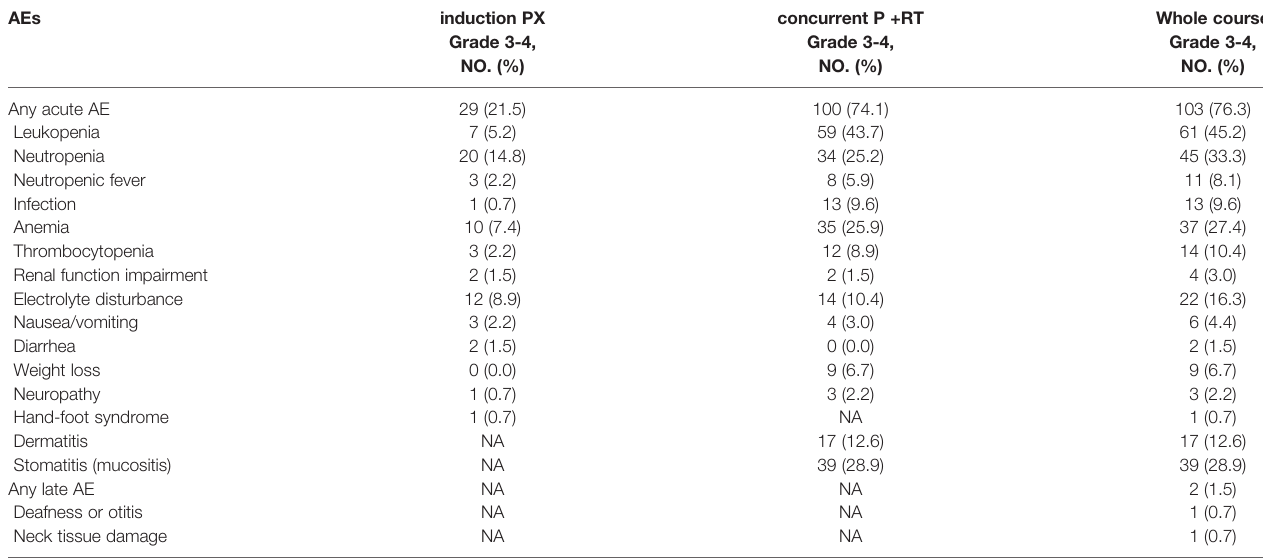
TABLE 4 | AEs, according to treatment phase and Grade # .